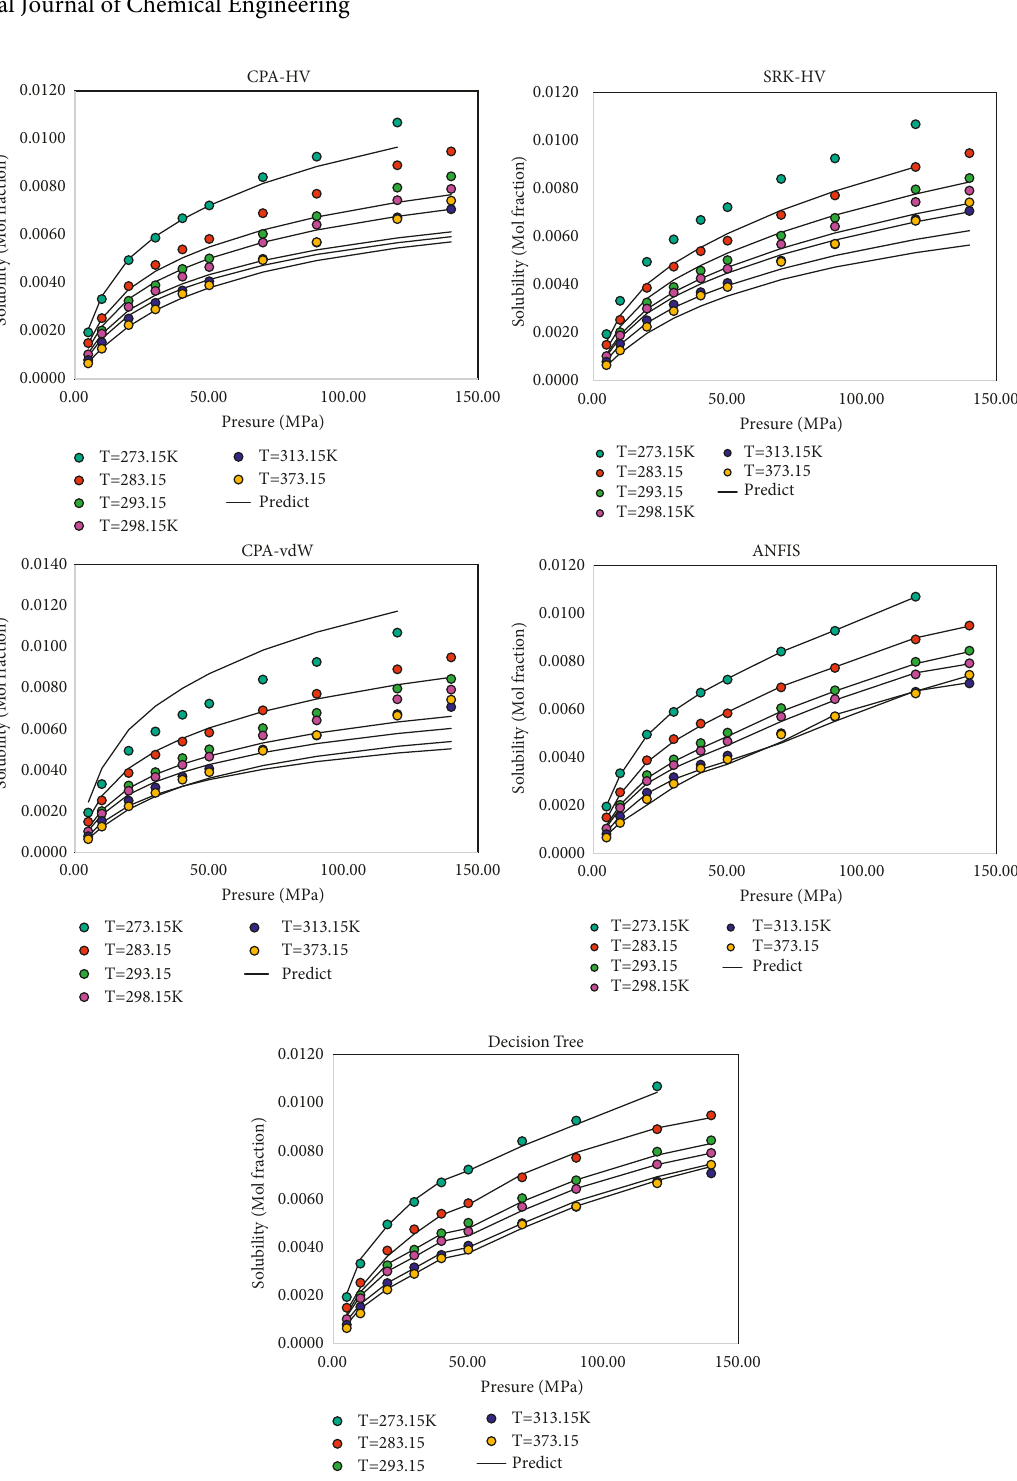
Figure 7: Comparison of predicted and experimental methane solubility values in wide ranges of pressure and temperature for different